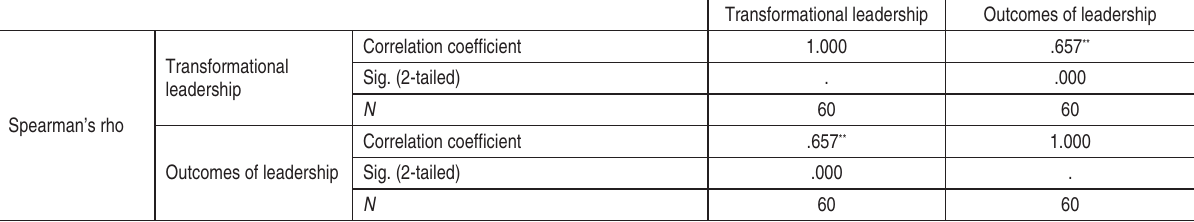
Table 6. Correlations between transformational leadership and outcomes of